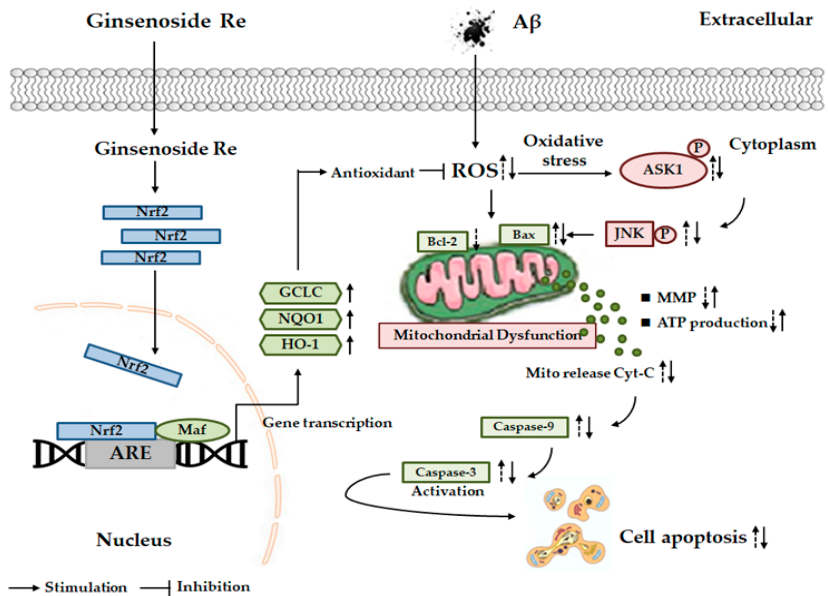
Figure 7. Scheme summarizing the protection of A β 25–35-induced SH-SY5Y cell mitochondrial dysfunction by ginsenoside Re via inhibits ROS / ASK-1 dependent mitochondrial apoptosis pathway and activation of Nrf2-antioxidant response pathway.